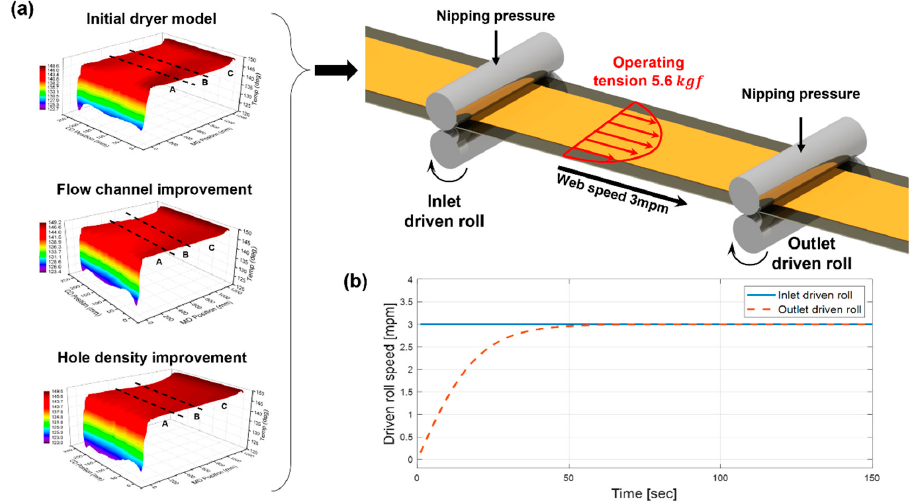
Figure 15. ( a ) Boundary conditions for the web strain analysis and ( b ) velocity profile of the driven roll. driven